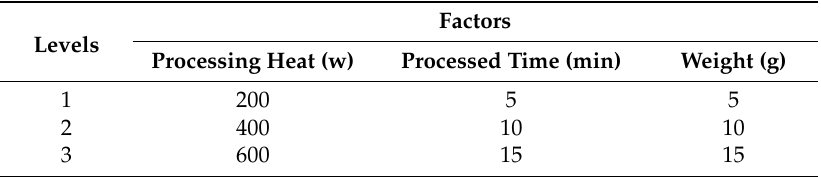
Table 5. Factors and levels of the orthogonal array design L9 (3) 4 matrix.